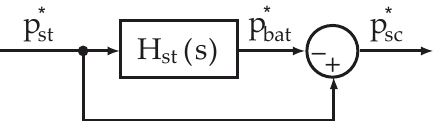
Figure 4. Proposed control scheme of the HRES storage system with the inclusion of a low-pass filter.